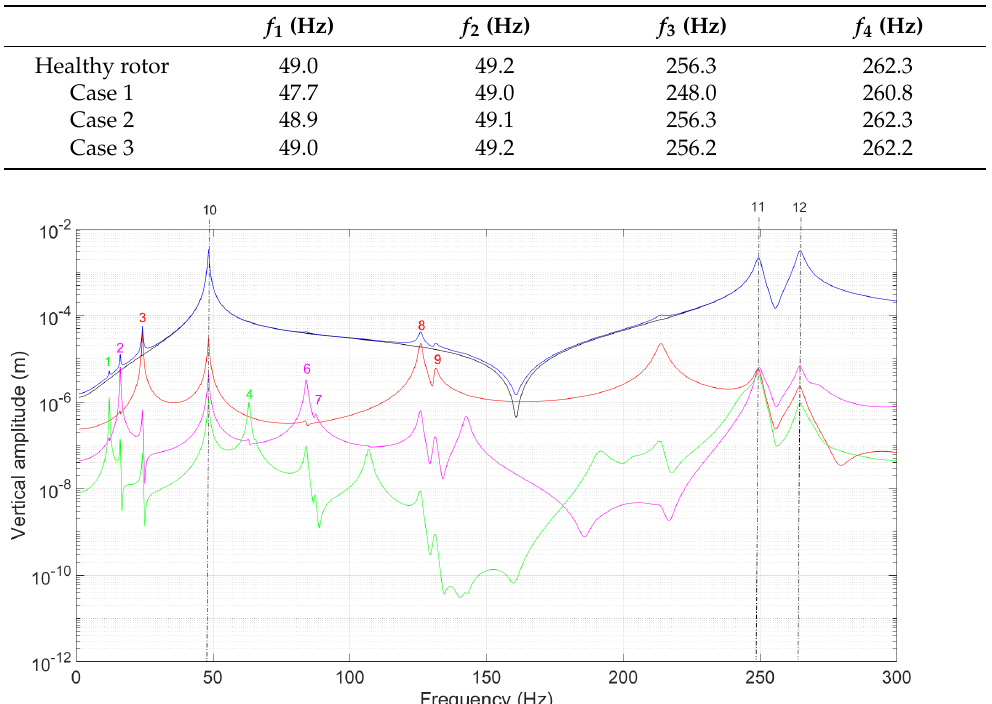
Table 4. Natural frequencies of the healthy or cracked rotor system at rest.